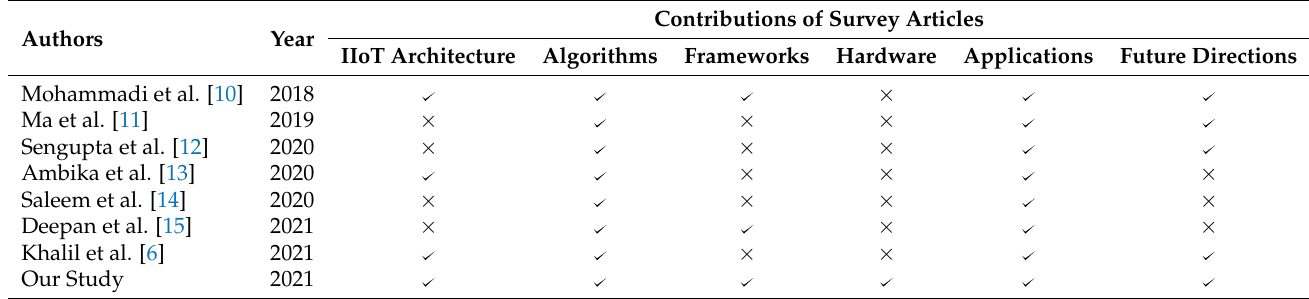
Table 1. A comparison of latest survey